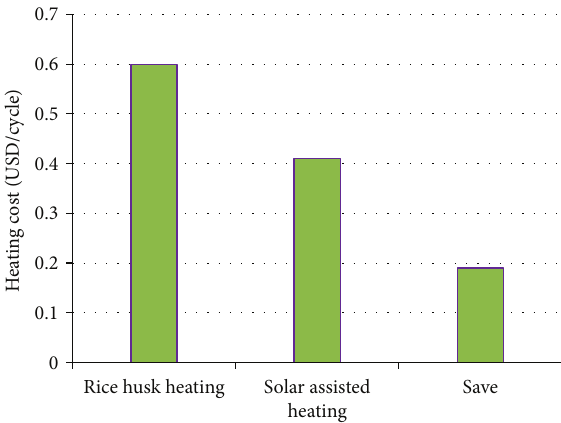
Figure 8: Cost of rice husk heating and solar assisted